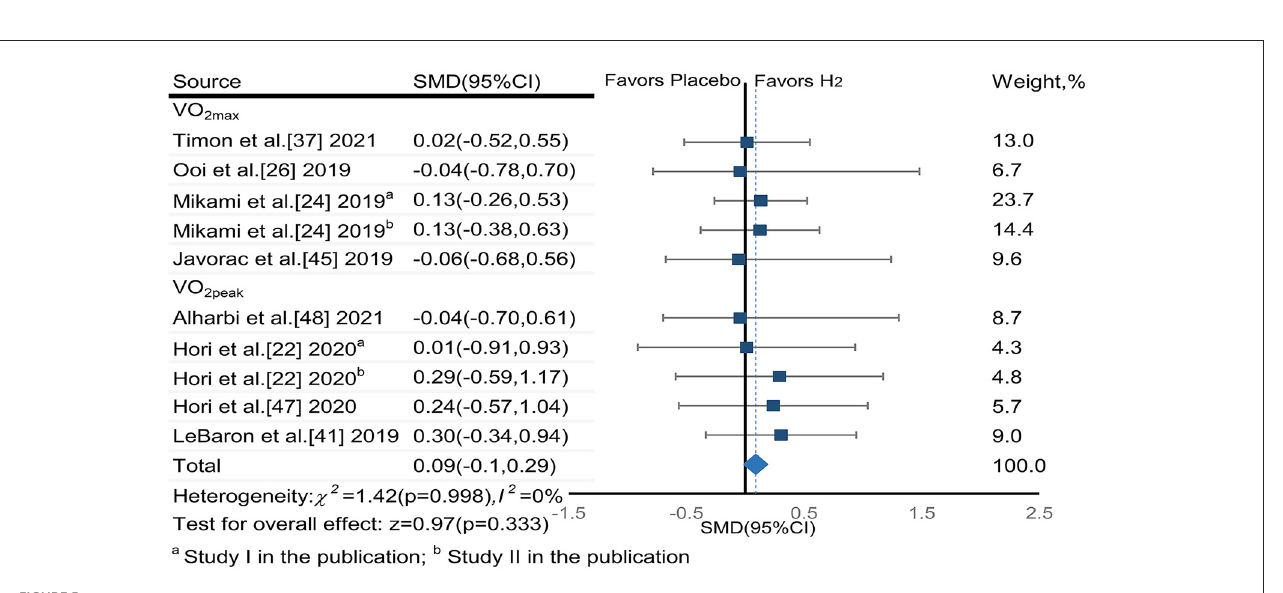
FIGURE5 The pooled effect size of H 2 intake on VO 2max (VO 2peak